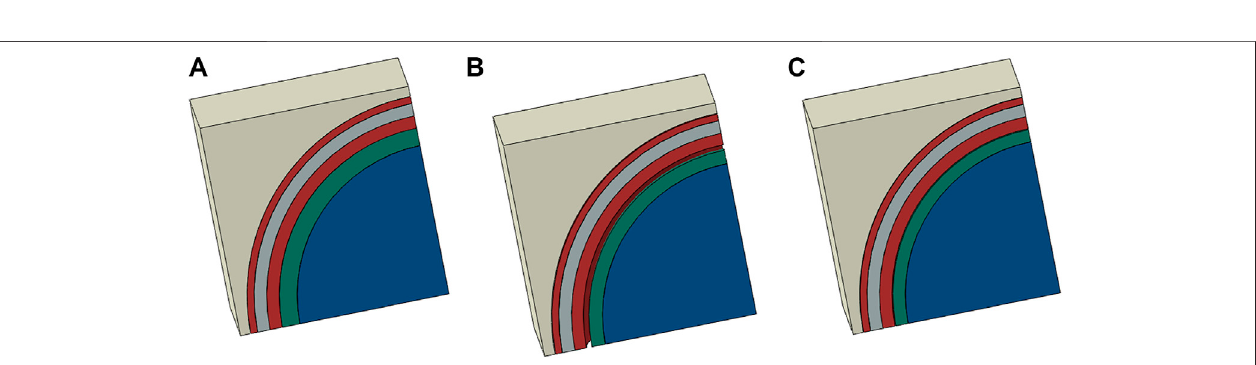
FIGURE 7 | Structural changes of FCM fuel RVE model at different irradiationtime. (A) 0 EFPD. (B) 200 EFPD. (C) 1,100 EFPD.